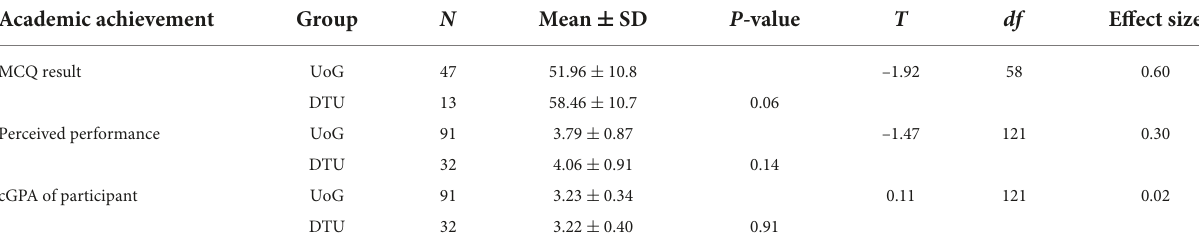
TABLE 3 Comparison of anesthesia students’ academic achievement at Debre Tabor University (DTU) and University of Gondar (UoG), 2021. Academic achievement Group N Mean ± SD